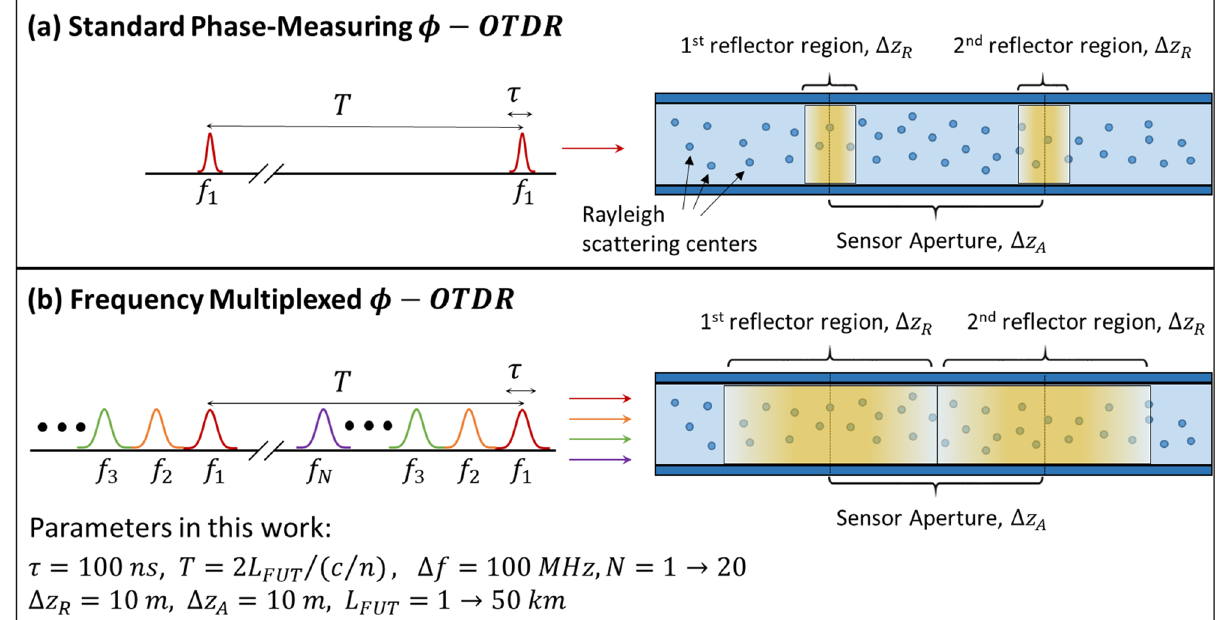
Figure 1. Schematic of operating principles of a standard ( a ) and frequency-multiplexed ( b ) phase measuring φ-OTDR system. The sensors are designed to measure the strain over a given sensor aperture by recording changes in the relative phase between RBS light from nearby reflector regions. Using frequency multiplexing, a train of N pulses can be injected into the fiber at once. This approach also enables longer pulses without compromising the sensor linearity—the reflector region size can be set equal to the desired sensor aperture